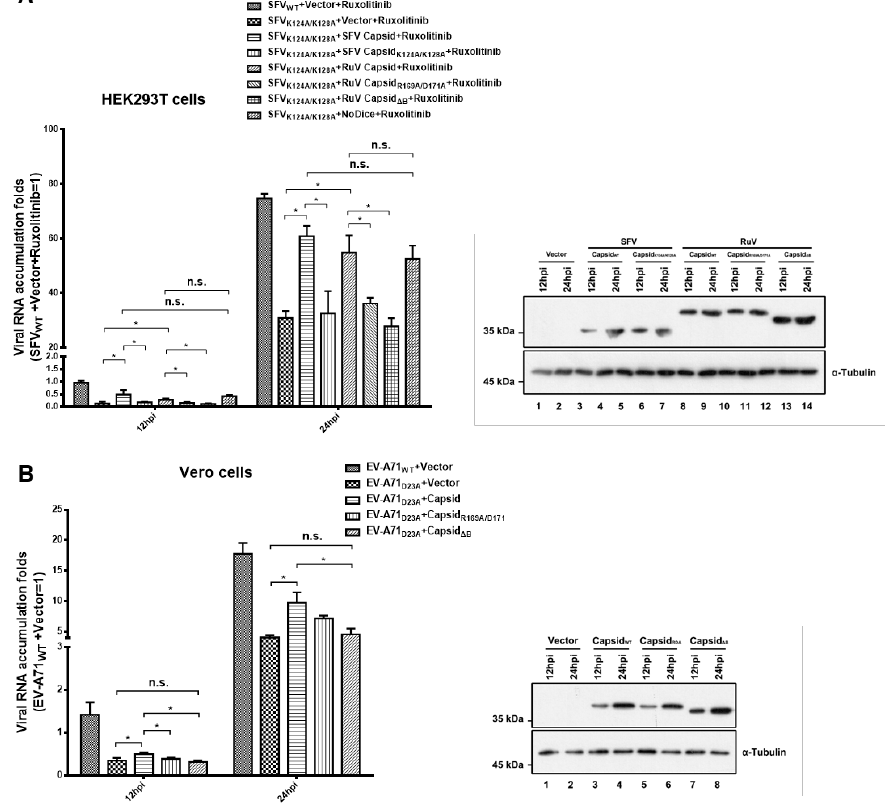
Figure 5. Ectopic expression of RuV capsid rescuing the replication of VSR-deficient SFV and EV-A71. ( A ) HEK293T or NoDice cells were transfected with either empty plasmid or a plasmid-encoded SFV capsid WT , capsid K124A/K128A , RuV capsid WT , capsid R169A/D171A , or capsid ΔB as indicated. At 24 hpt, the cells were treated with ruxolitinib (10 μM) and then infected with SFV WT or SFV K124A/K128A at an MOI of 1. At 12 and 24 hpi, the levels of SFV genomic RNAs in cells were deter- mined by qRT-PCR. ( B ) Vero cells were transfected with either empty plasmid or a plasmid-en- coded SFV capsid WT , or capsid K124A/K128A as indicated. At 24 hpt, the cells were infected with EV- A71 WT or EV-A71 D23A at an MOI of 1. At 12 and 24 hpi, the levels of EV-A71 genomic RNAs in cells were determined by qRT-PCR. Cellular lysate was harvested and analyzed by Western blotting. Empty vector was used as a mock control. All data represent the means and standard deviations of three independent experiments. * p < 0.05 as measured by two-way ANOVA, in GraphPad Prism. n.s., not significant. 4. Discussion RuV is the etiological agent of a series of birth defects termed CRS that remains a global major public health concern, and better understanding of virus–host interactions would be helpful for identifying the pathogenesis of the viral disease and developing an antiviral therapy. RNAi is an antiviral response conserved in all eukaryotes, including mammals, and viruses encode VSRs to antagonize RNAi [49]. In this study, we found that the RuV-encoded structural protein capsid displayed VSR activity that suppresses Dicer- mediated siRNA production by sequestrating dsRNA and siRNA-induced RNAi in mam- malian cells. Moreover, the VSR activity of the RuV capsid can rescue the defective repli- cation of VSR-deficient viruses. Therefore, our findings support the notion that the RuV capsid can act as the VSR to facilitate viral replication by shielding viral dsRNA from Dicer cleavage and siRNA from RISC assembly. Although belonging to different families, RuV and SFV share similar motif composi- tions, suggesting that their encoded proteins are likely to possess similar functions. There- fore, it is a rational prediction that the RuV capsid also contains VSR activity as does its